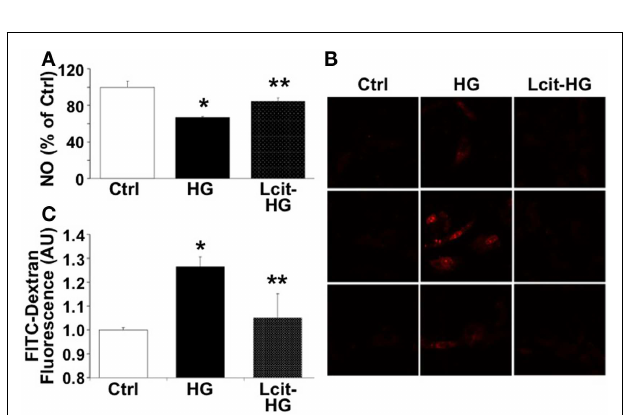
FIGURE 8 | KIM-1 immunofluorescence staining . Kidney injury molecule 1 (KIM-1) antibody was used for immunofluorescent staining (red) of frozen sections from control (Ctrl), untreated diabetic (Diab), and L -cit-treated diabetic (Lcit-Diab) rats. Nuclei were counterstained with DAPI (blue). (A) Representative photomicrographs show negative staining for KIM-1 in control kidneys. Conversely, an increased number of tubules positively stained for KIM-1 is observed in kidneys of untreated diabetic rats.The number of positive tubules was dramatically decreased in kidneys of L -cit-treated diabetic rats. (B) Staining score determined by counting the number of positive tubules per field, using 40 × magnification lens. Five to seven fields were examined in each kidney section ( n = 3–4). * p < 0.001 vs. Ctrl, ** p < 0.001 vs. Diab.